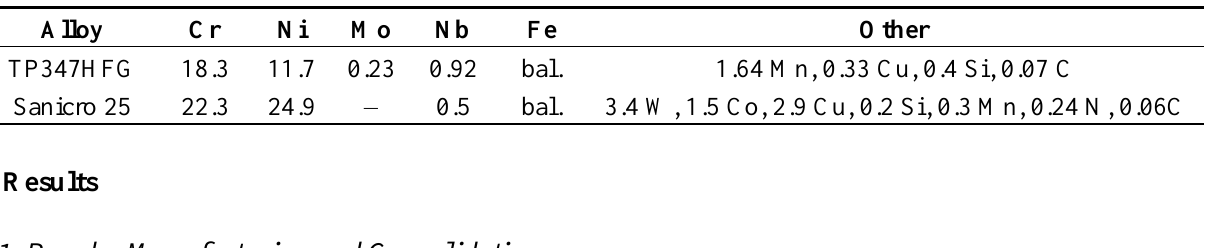
Table 2. Chemical composition of bulk materials Sanicro 25 and TP347HFG by optical emission spectroscopy